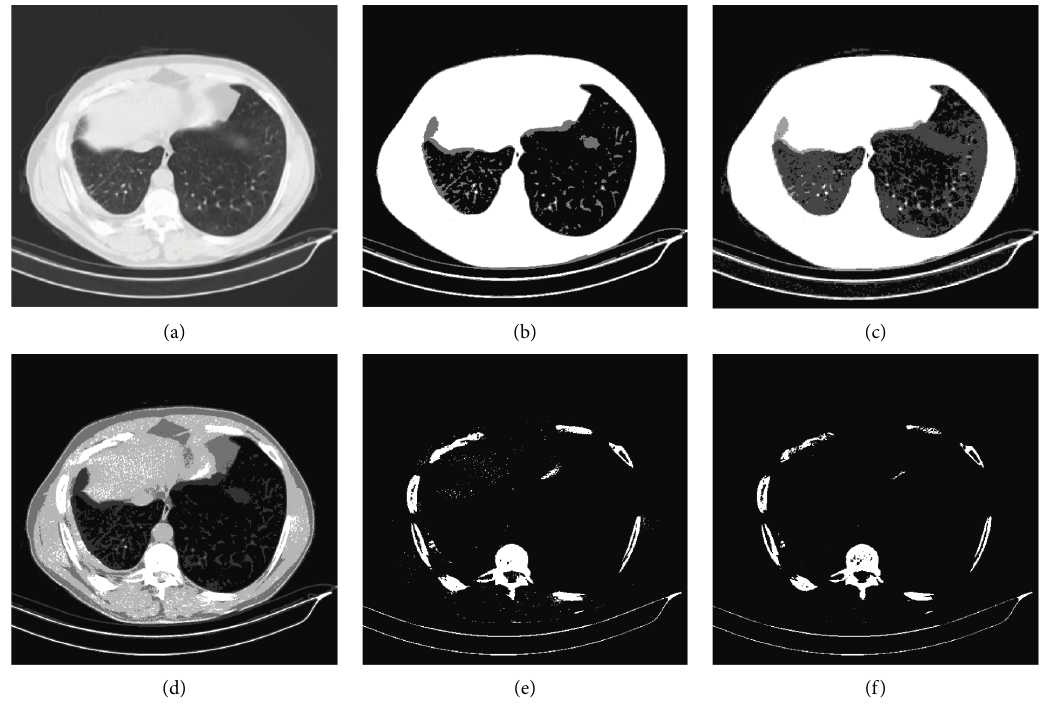
Figure 9: The comparison outcomes. (a) Original CT image-2; (b–d) segmentation result of threshold levels 2,3, and 4, respectively, of the proposed approach; (e) segmentation results obtained by Tao [21]; (f) segmentation results obtained by Tang